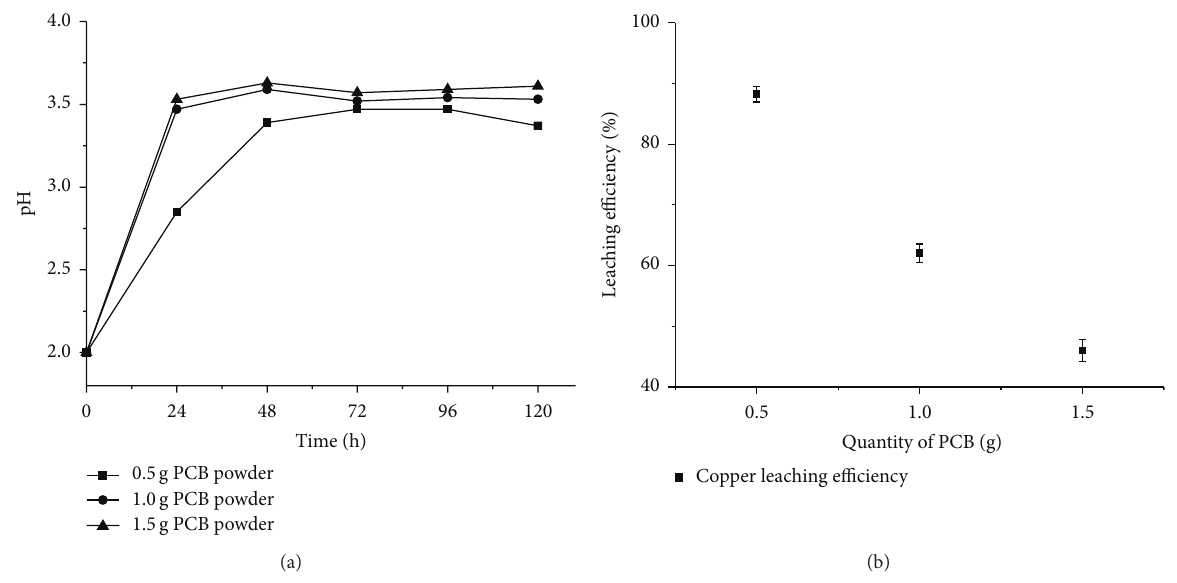
Figure 3: Different quantity of PCB and medium pH changed with time (a) and 5 days leaching and copper leaching efficiency (b).